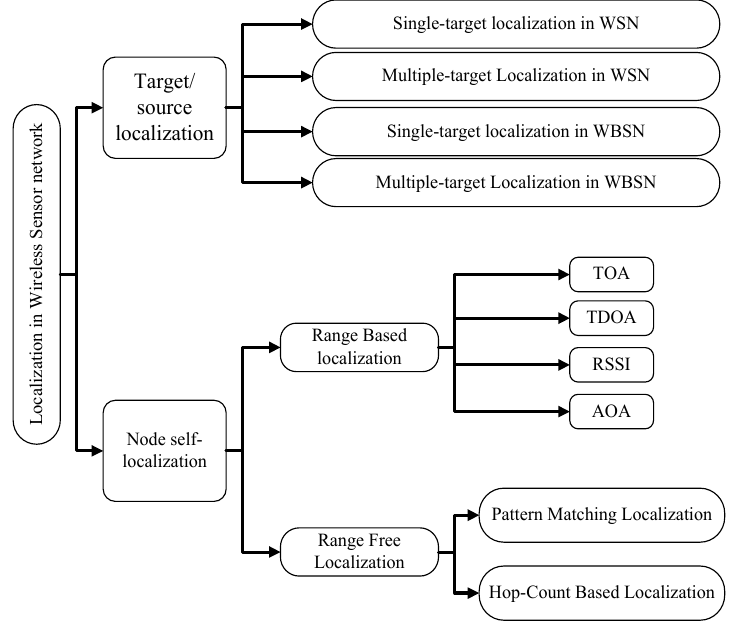
Figure 1. Classification of localization